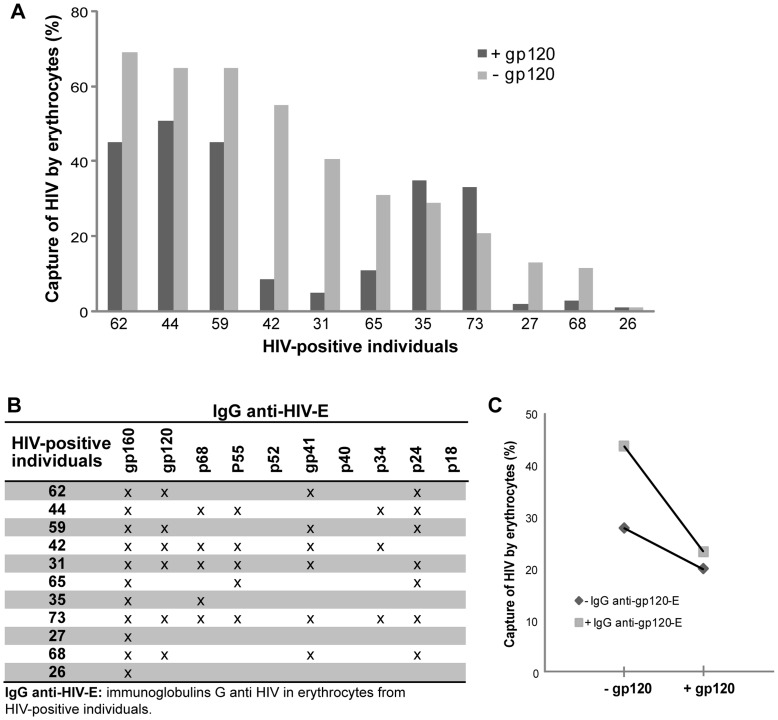
Inhibition of HIV capture by recombinant gp120.(A) Percentage of HIV capture by erythrocytes from HIV-positive individuals (11 of 75 belonging to Table S1). Erythrocytes were previously incubated with soluble gp120 (Inhibition of viral capture assay, dark gray bars) or without gp120 (viral capture assay, light gray bars). HIV capture by erythrocytes was inhibited by viral gp120 (p<0.05) and the variation between individuals was significant (p<0.05) (two-way ANOVA with random effects). This result indicates that the large-scale inhibitory effect varies according to the subject from whom erythrocytes were obtained. (B) The table lists IgG anti-HIV antibodies present in the erythrocytes of the 11 individuals. All of them have IgG anti-gp160, and 6 individuals with IgG anti-gp120 also present IgG anti-gp41 on their erythrocytes (patients 62, 59, 42, 31, 71 and 68). (C) The mean percentage of viral capture of HIV by erythrocytes with or without inhibition with soluble gp120 is plotted in individuals who present IgG anti-gp120 in erythrocytes (+ IgG anti-gp120-E, line with square) and in individuals who do not present IgG anti-gp120 in erythrocytes (- IgG anti-gp120-E, line with rhomb). The inhibitory effect mainly occurs in individuals with IgG anti-gp120 on their erythrocytes (p<0.05, repeated measures analysis).